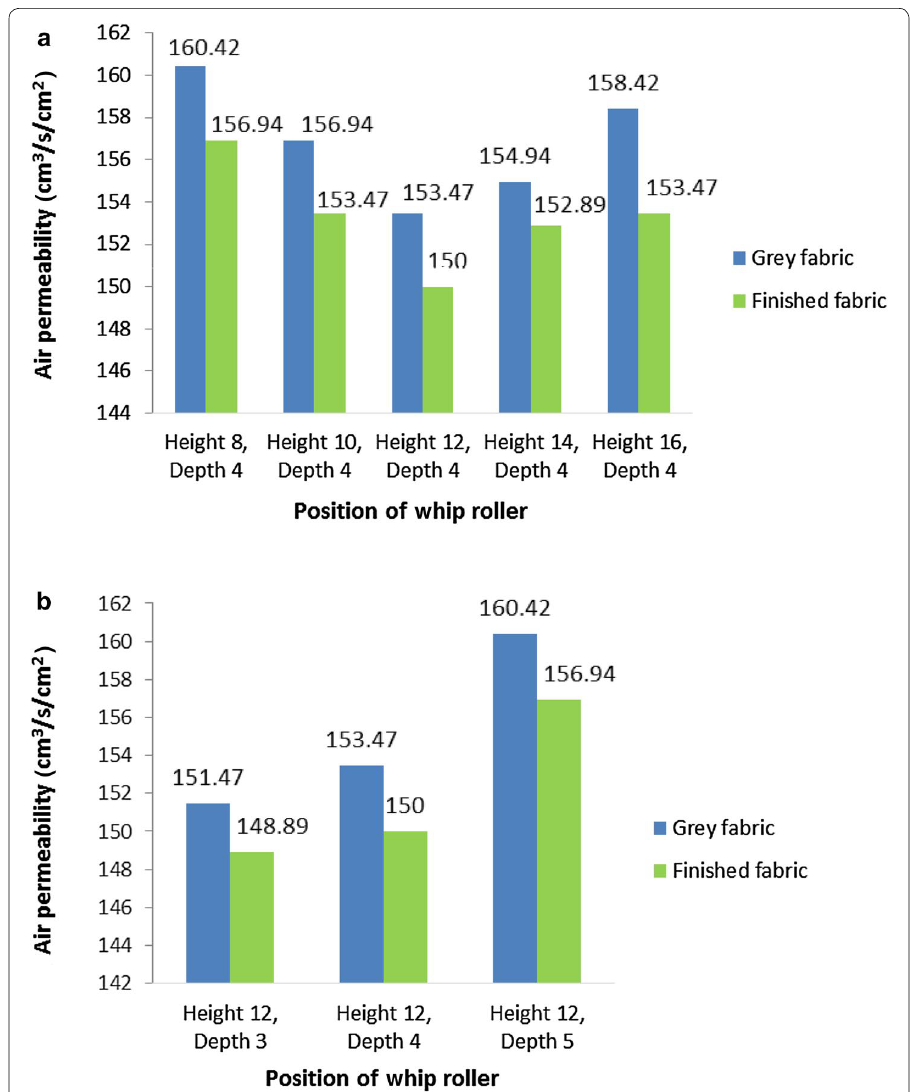
Fig. 10 a Air permeability at variable height and constant depth of whip roller. b Air permeability at constant height and variable depth of whip